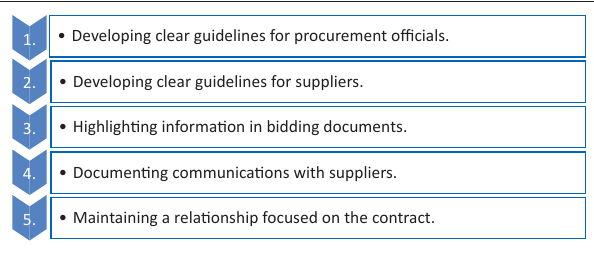
FIGURE 2: Five-stage